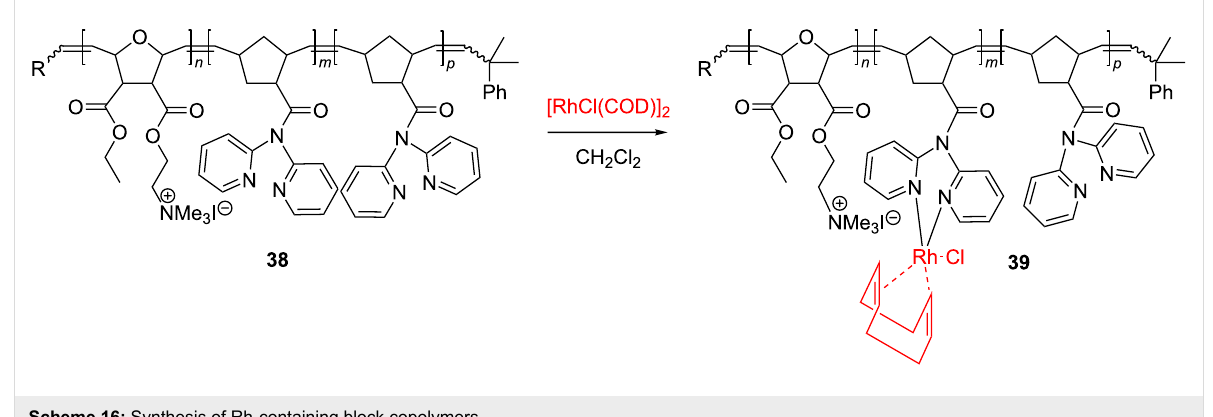
Scheme 16: Synthesis of Rh-containing block copolymers.